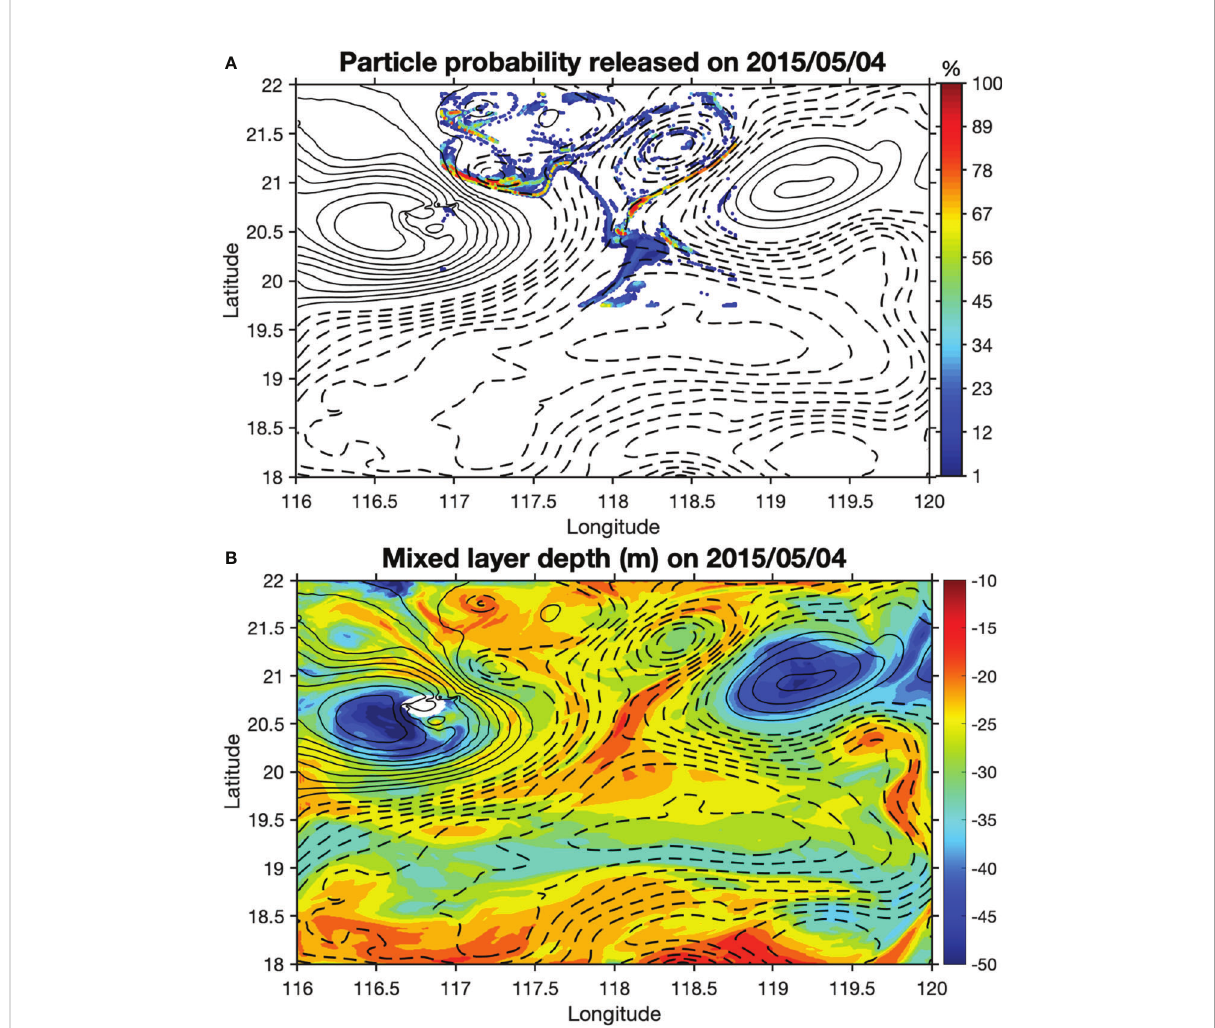
FIGURE 6 The spatial distribution of particle probability of staying in the mixed layer in May 2015 (A) and the spatial distribution of modeled mixed layer depth (m) on 4 May 2015 (B) . The particles were released at 50-m depth on 4 May. The contours are the SLA isolines with solid and dashed lines denoting positive and negative values,